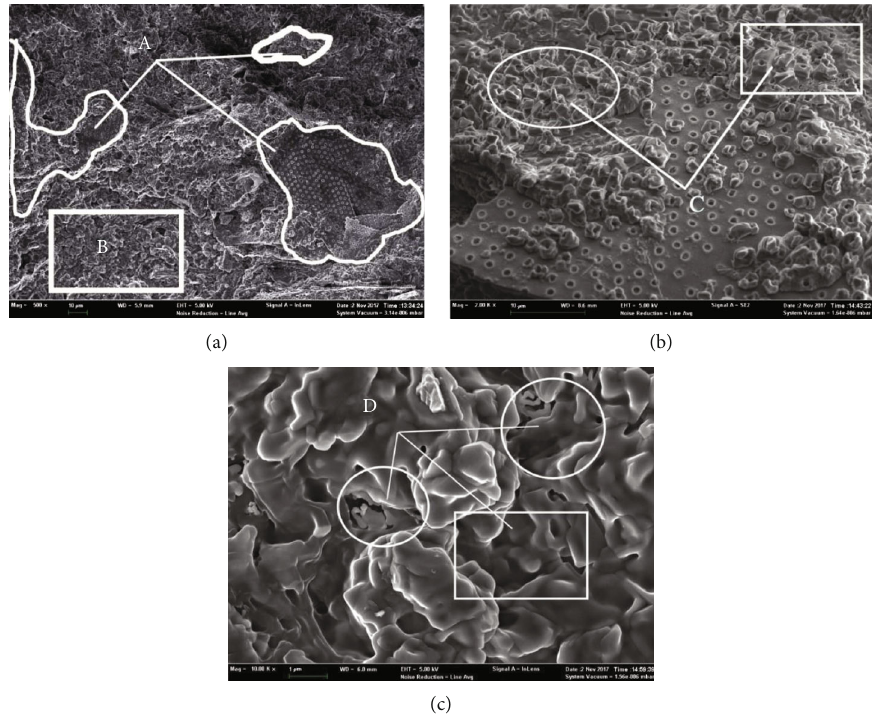
Figure 13: SEM image of undisturbed deep-sea sediments. (a) Sediments magni fi ed 500 times. (b) Sediments magni fi ed 2000 times. (c) Sediments magni fi ed 10000